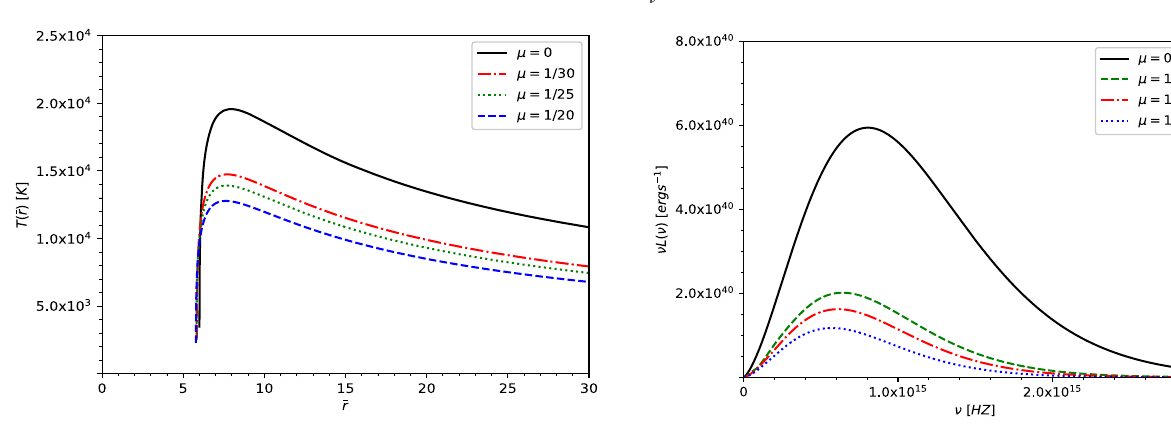
Fig. 5 Theemissionspectrum ν L (ν) oftheaccretiondiskaroundaBH in EACT for different negative values of μ , as a function of frequency ν